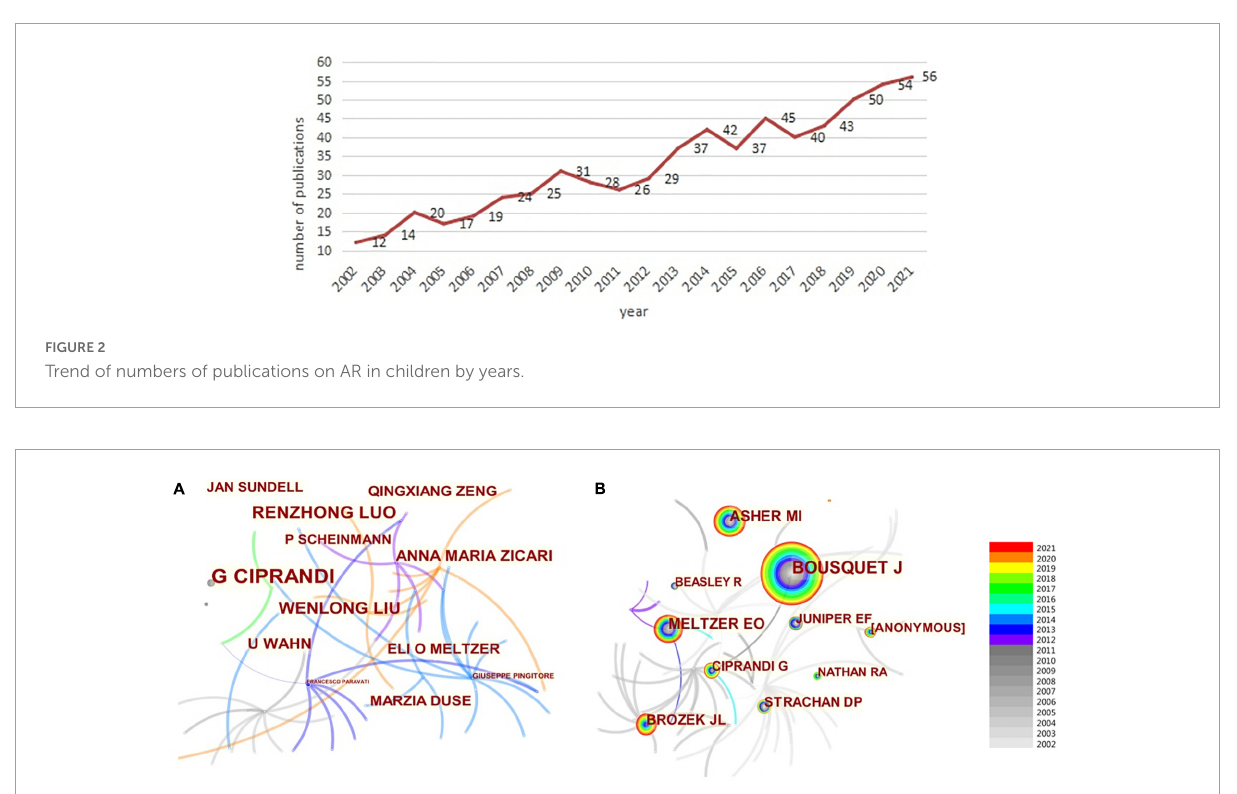
FIGURE1 Flowchart of the search process for included articles.